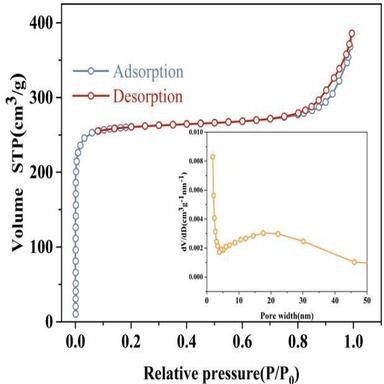
Specific surface area and pore size of Fe-UiO-66.